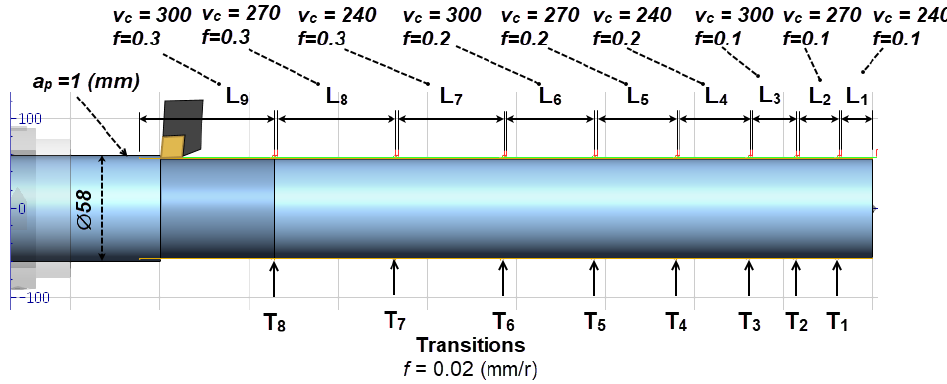
Figure 5. Machining plan for each workpiece was performed with one depth of cut.